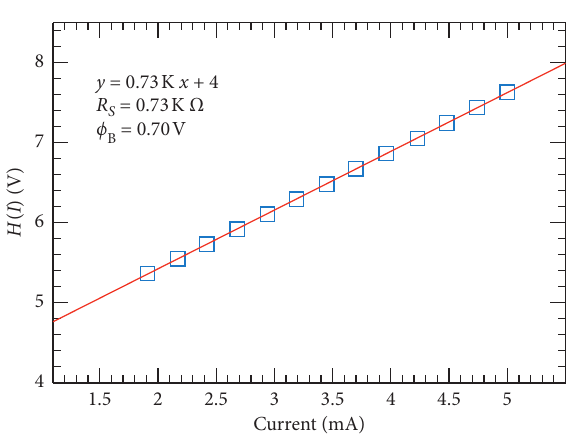
Figure 6: dV / d (1n I ) vs. forward current.